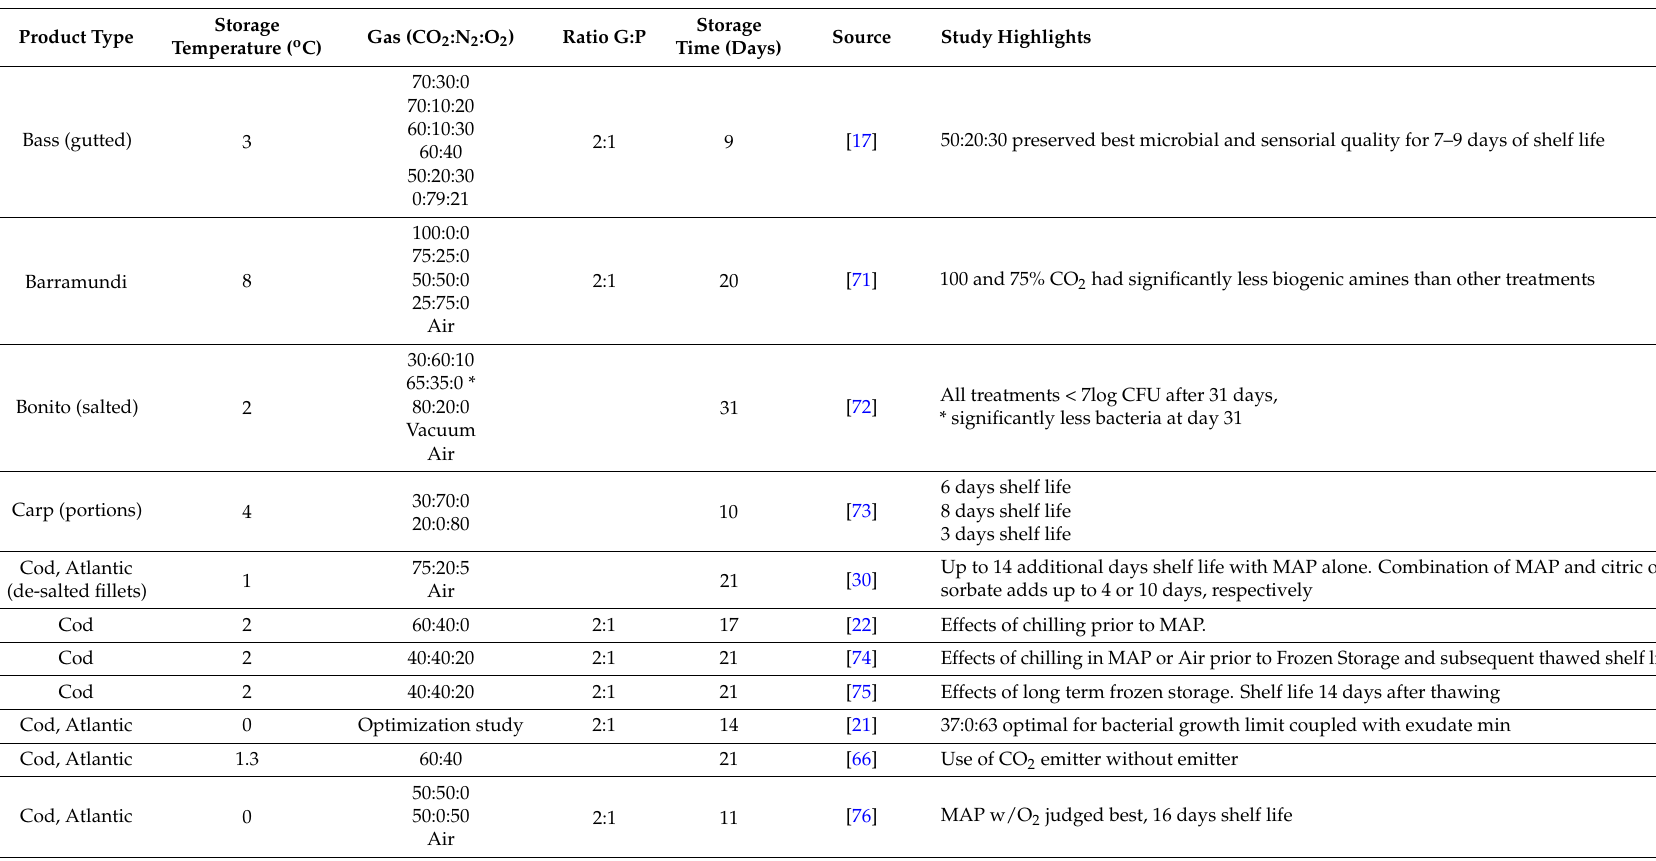
Table 1. Selected studies published from 2000 to 2016 reporting on the application of modified atmospheres for shelf life extension of fish and fishery products. Product